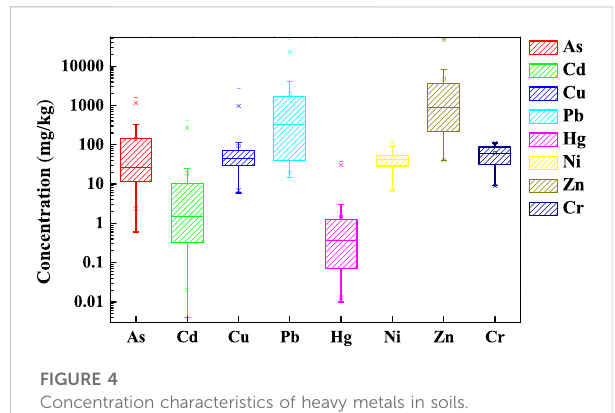
FIGURE 4 Concentration characteristics of heavy metals in soils.